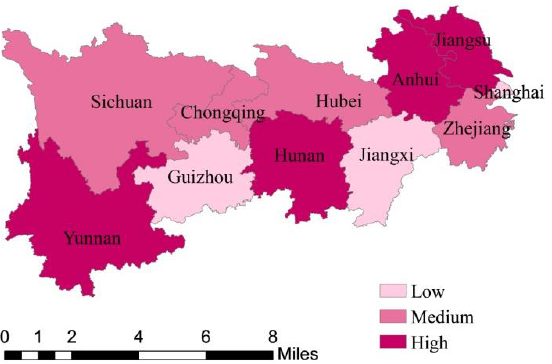
Figure 3. Spatial distribution of GTFP (Green Total Factor Productivity) in the YREB (Yangtze River Economic Belt) from 2009 to 2018.